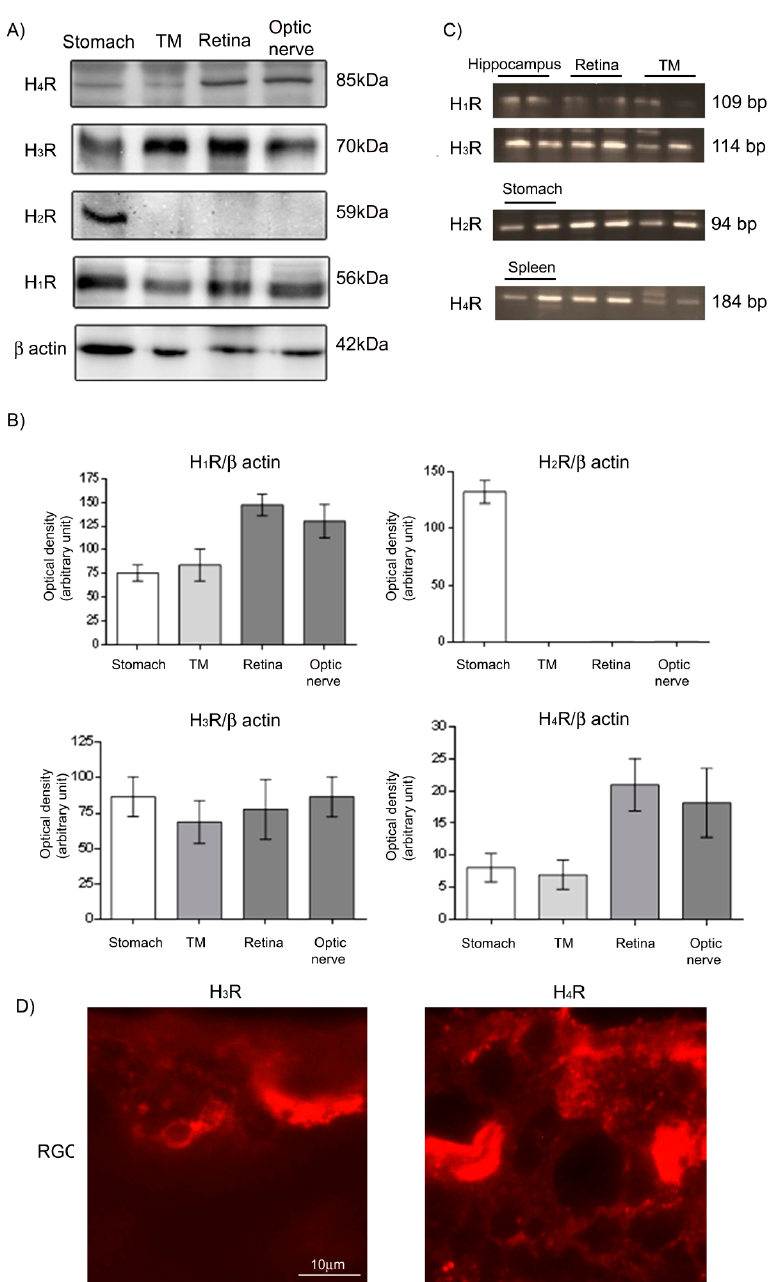
Figure 1. ( A ) Protein expression of histamine receptor subtypes by Western blot analysis; ( B ) optical densitometry of protein expression, n = 5; ( C ) mRNA expression by RT-PCR of histamine receptor subtypes in the trabecular meshwork (TM), retina and hippocampus, n = 5; ( D ) representative images of H 3 and H 4 receptors (H 3 R and H 4 R) in retinal ganglion cells (RGC) at 100 × magnification. The presence of mRNA and protein expression of histamine H 3 R led us to investigate the effects of different H 3 R antagonists (GSK189254, ciproxifan and DL 76) on IOP reduction in models of ocular hypertension.